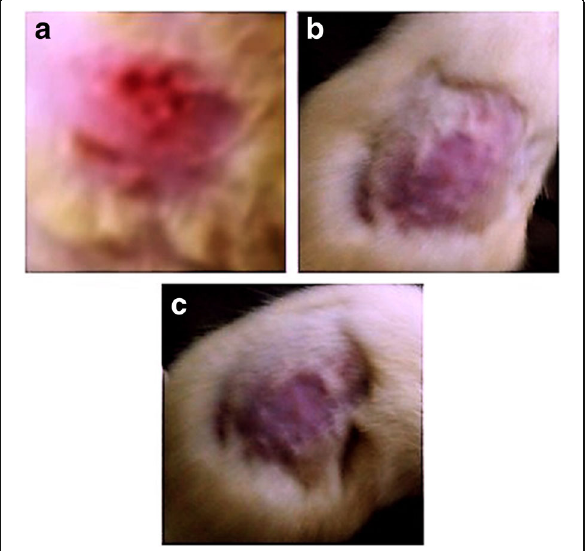
Fig. 1 Photographic representation of effect of E. hirta ointment at the different concentrations over skin after 7 days where a = Group 1: Aqueous solution of 0.8% formalin, erythema and edema skin rash and inflammation was observed. b = Group 2: 50 mg of 5% w /w ethanolic extract of E. hirta whole plant ointment, no lesion occur. c = Group 3: 50 mg of 10% w /w ethanolic extract of E. hirta